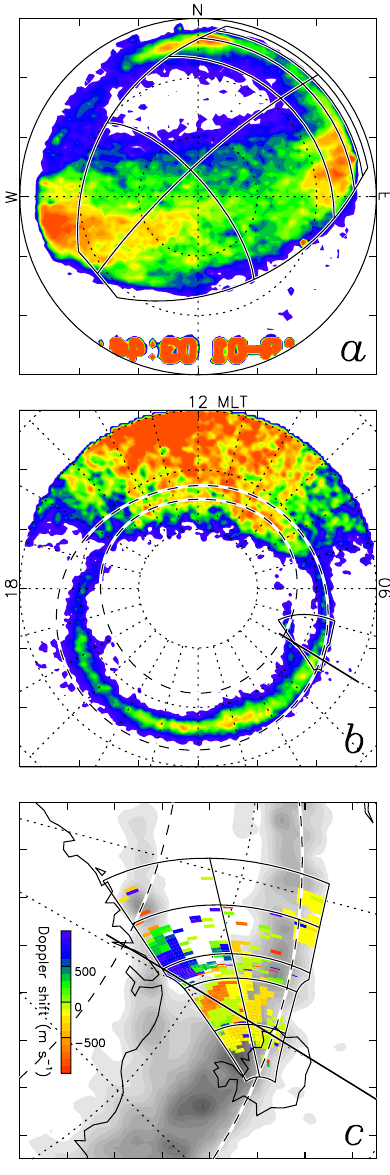
Fig. 3. Near simultaneous observations of the aurora from the ground and space, together with concurrent radar measurements, all from near 03:44UT. ( a ) ASC image from 03:44:00 UT, aligned with the magnetic cardinal points. The north-south line is the mag- netic meridian from which keograms are formed. Also shown is the projection of the radar field-of-view. Red features at the bottom of the image are timing information. ( b ) An auroral image from the IMAGE FUV/WIC instrument, taken at 03:44:34 UT. Super- imposed is the K p = 3 statistical oval (dashed lines), the ASC meridian, and the radar field-of-view. ( c ) The relationship be- tween Doppler shift, observed by the radar during the scan starting 03:43:34 UT, and auroral luminosity as measured by IMAGE. In the radar field-of-view every 15th range gate is marked. The kink in the field-of-view between range gates 30 and 45 corresponds to a change in projection altitude from the E-region (nearer ranges) to the